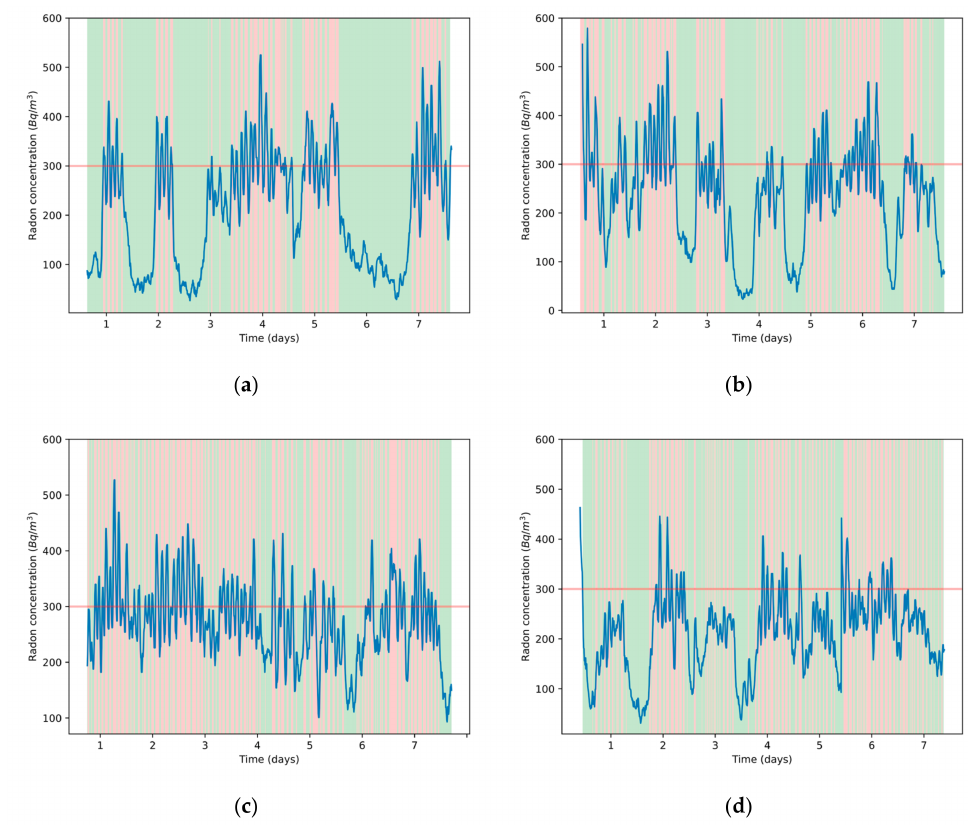
Figure 5. Radon concentration evolution and airflow control system activation (red vertical bars) during a week for the tested interpolation time windows: ( a ) 10 min; ( b ) 30 min; ( c ) 1 h; ( d ) 2